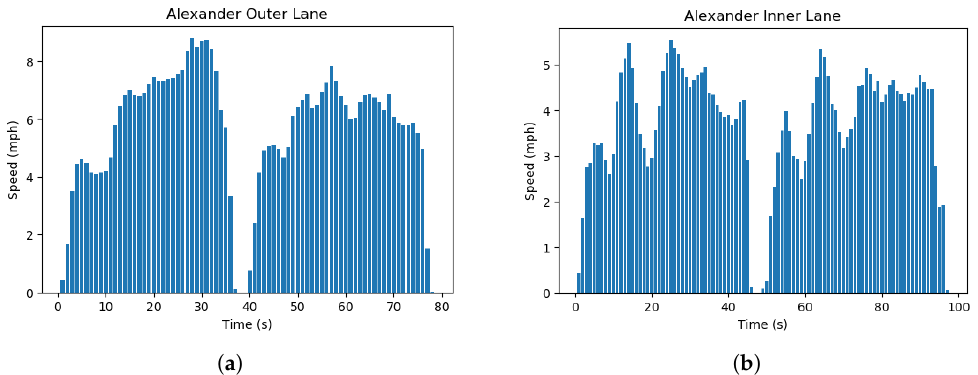
Figure A6. Author Alexander Quezada’s driving graphs for outer and inner lane.